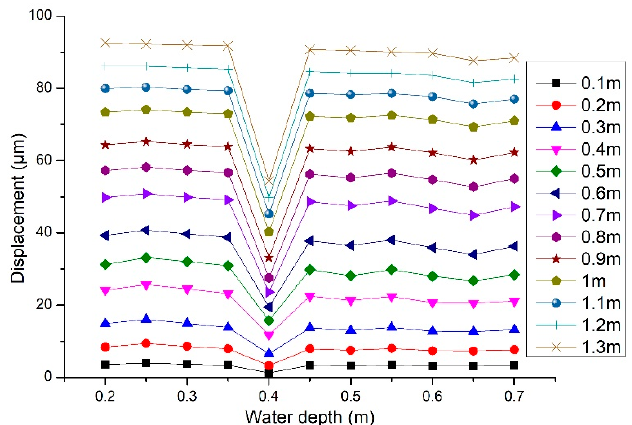
Figure 8. Displacement responses versus water depth of tower model on Line 1.